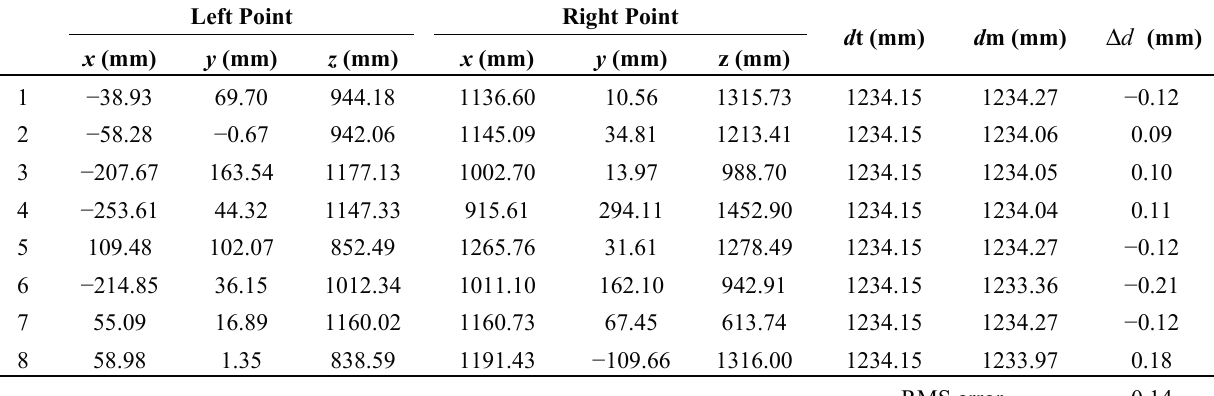
Table 1. Evaluation of the global measurement accuracy (mm).